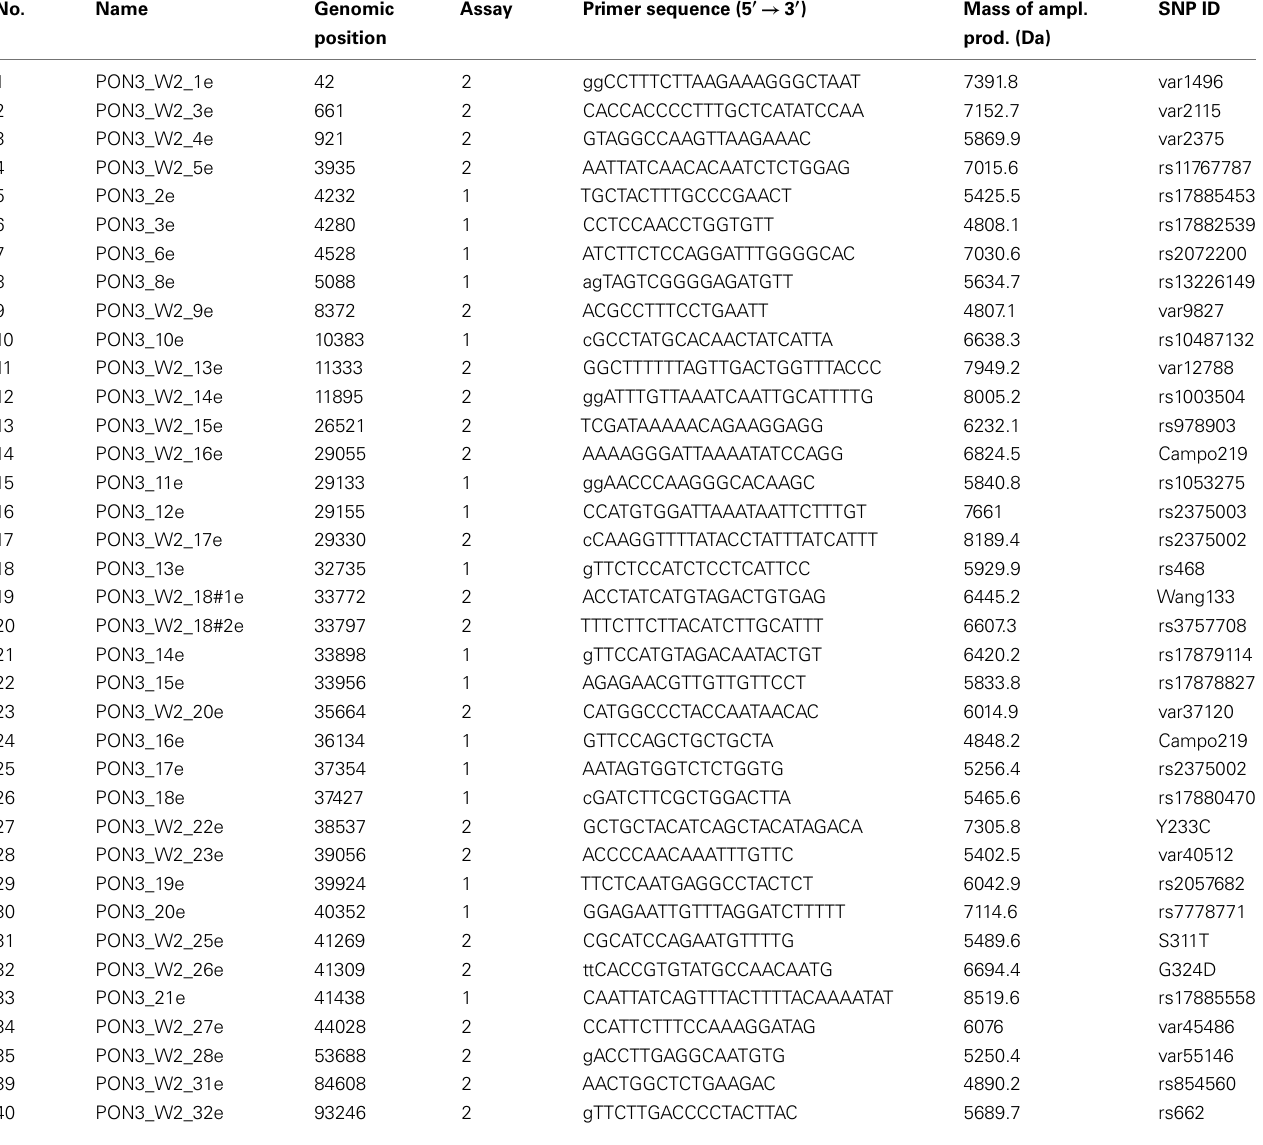
TableA5 | Extension primers used in MALDI-TOF MS